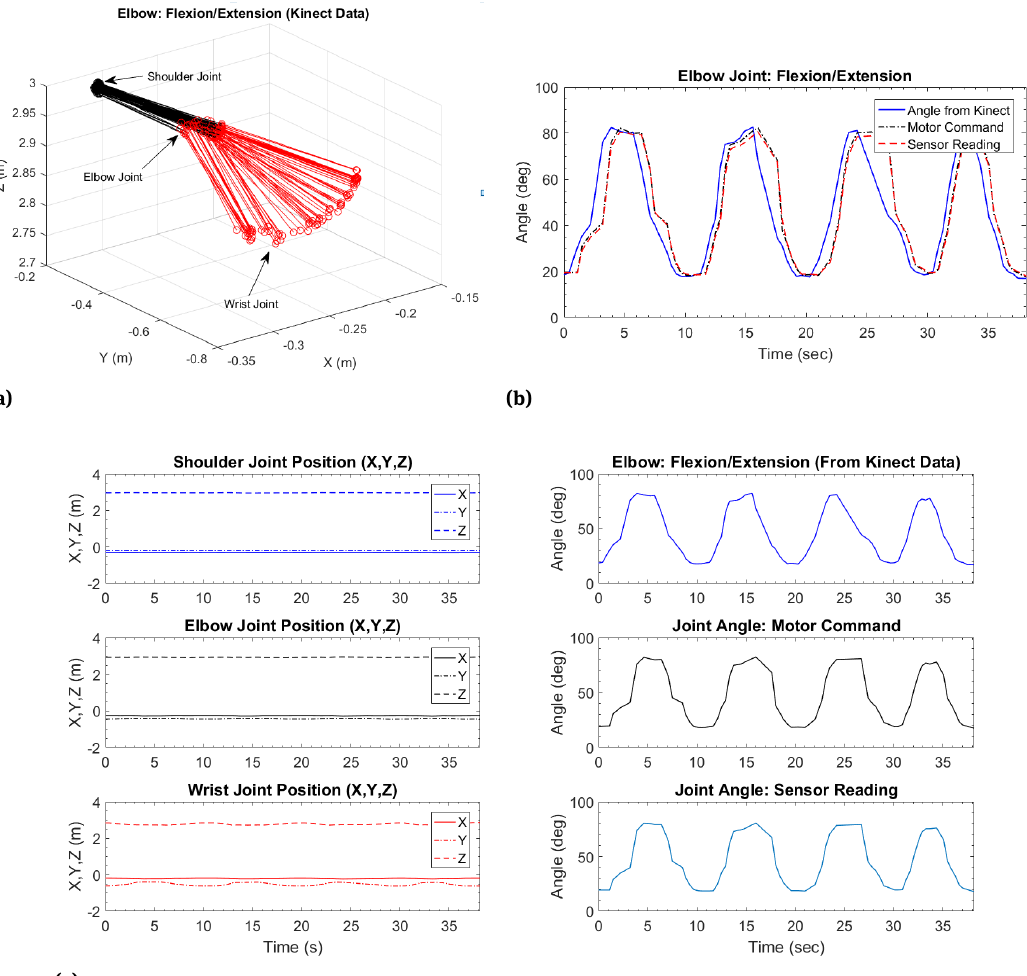
Figure 14: Elbow flexion/extension teleoperation. (a) Skeleton with joint coordinate from Kinect, (b) comparison between joint angles from Kinect and NAO robot, (c) coordinate data and joint angles from Kinect and NAO robot